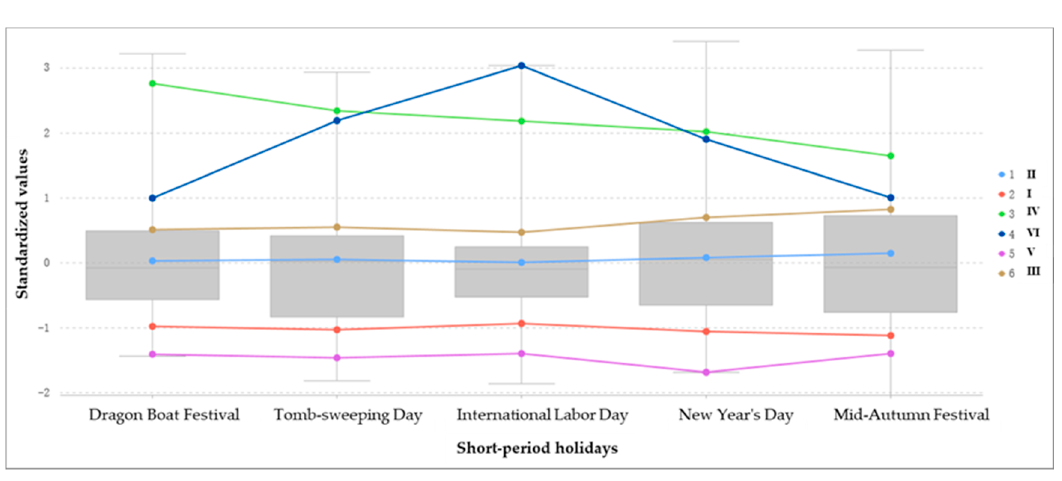
Figure 5. Mean line boxplots for regionalization results of scenic spots in Nanjing.